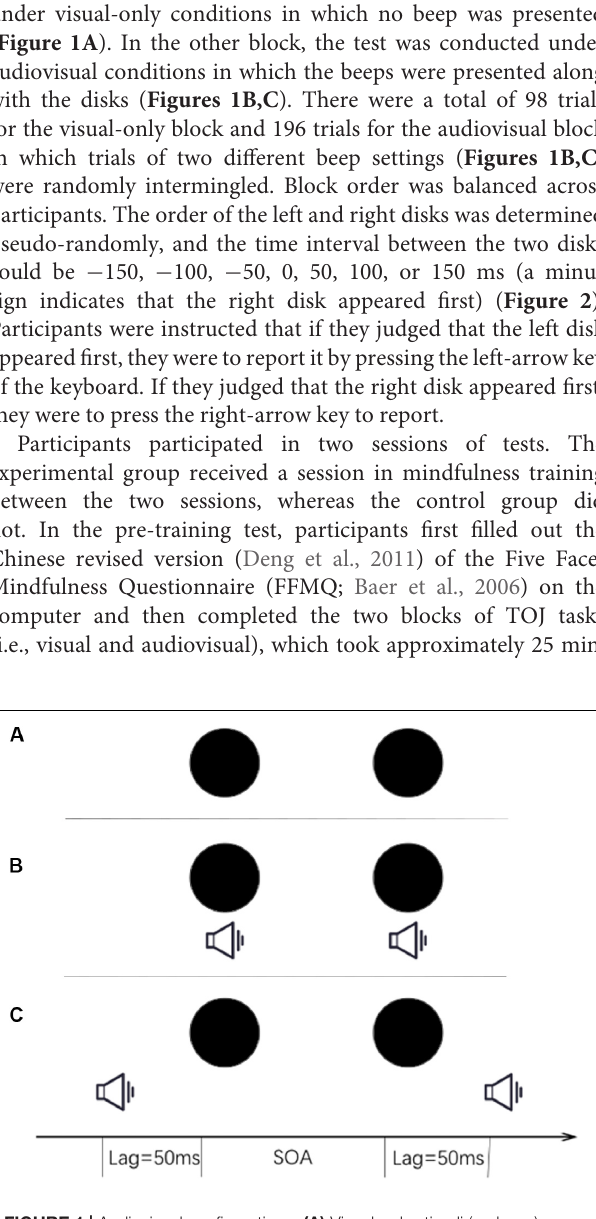
FIGURE 1 | Audiovisual configurations. (A) Visual-only stimuli (no beep). (B) Two disks with two synchronized beeps. (C) Two disks with a leading beep (50 ms ahead of the first disk) and a lagging beep (50 ms behind the second disk). There were seven levels of stimulus onset asynchrony (SOA): − 150, − 100, − 50, 0, 50, 100, and 150 ms (minus sign indicates that the right disk appeared first). The disks randomly appeared on the left or right side, separated by the above